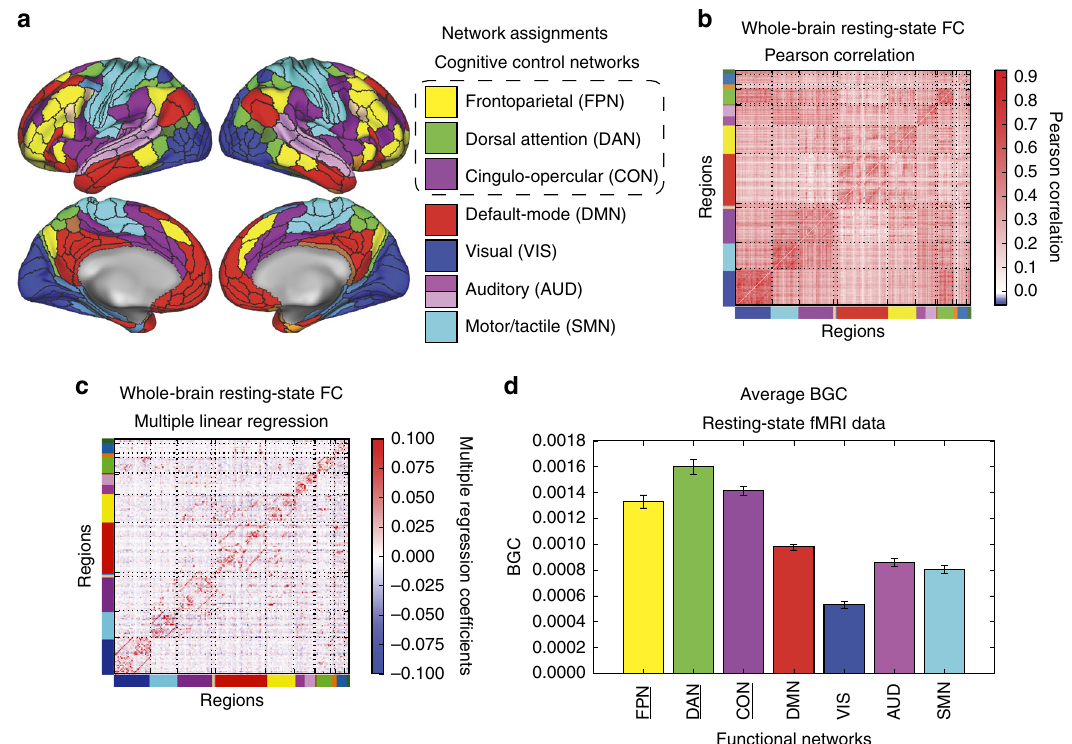
Fig. 3 Large-scale network organization during rest. a Using a recently released, multi-modal parcellation of the human cerebral cortex 36 , we assigned each region to a functional network using the Generalized Louvain method for community detection with resting-state fMRI data. We designated functional labels to seven networks that were replicated with other network assignments 22 – 24 . b Whole-brain resting-state FC matrix computed using Pearson correlation between regions in a . Colors along the rows and columns denote network assignments from a . c Whole-brain resting-state FC matrix computed using multiple linear regression. For every region ’ s time series, we fi tted a multiple linear regression model using the time series of all other regions as regressors of the target region. Multiple regression FC strongly reduced the chance that a connection was indirect, since FC estimates are based on unique shared variance. We used multiple regression FC for information transfer mapping, suggesting the estimated information transfers were likely direct rather than indirect. d Averaged BGC of resting-state fMRI for each de fi ned functional network. Cognitive control networks ( underlined ) had higher average BGC estimates relative to non-cognitive control networks (i.e., DMN and sensorimotor networks; FWE-corrected p < 0.05). Error bars re fl ect